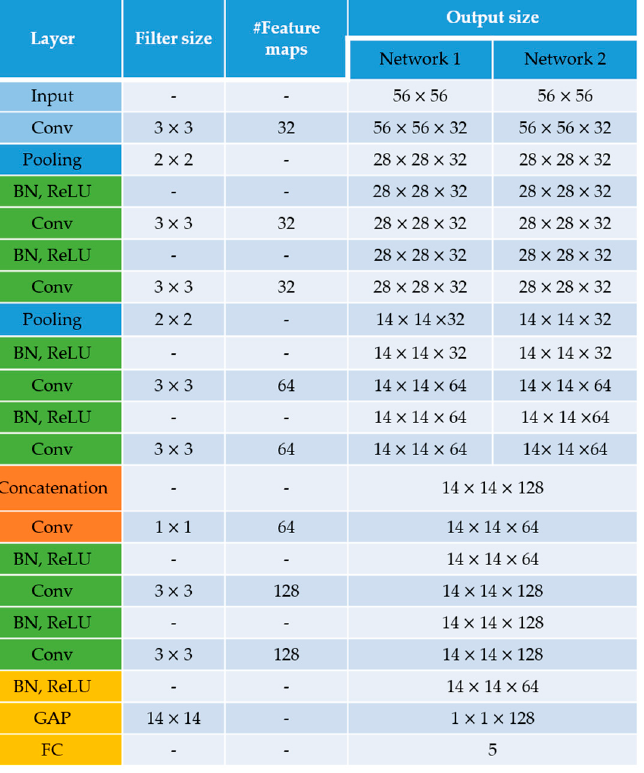
Figure 5. Architecture of the residual networks. The residual blocks are shown in green. Here, “Conv”, “BN”, “ReLU”, “GAP” and “FC” denote, respectively, the convolutional layer, the batch normalization layer, the rectified linear unit (ReLU) layer, the global average pooling layer and the fully connected layer. “Pooling” denotes the maximum pooling layer and “Concatenation” denotes the layer that performs feature concatenation from the two networks.